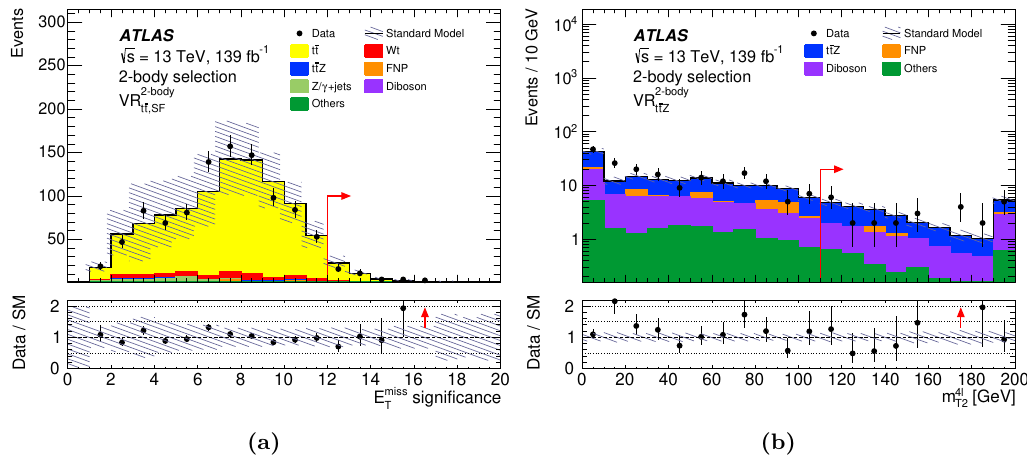
Figure 3 . Two-body selection. Distributions of the E miss in VR 2-body tt Z